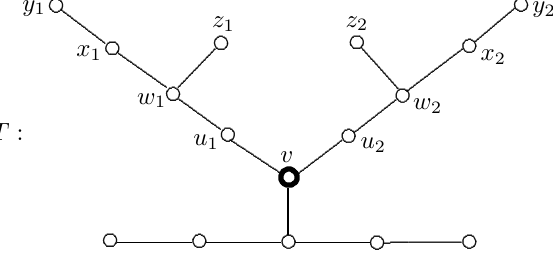
Figure 2: A tree T with twin branches of size 5 at v